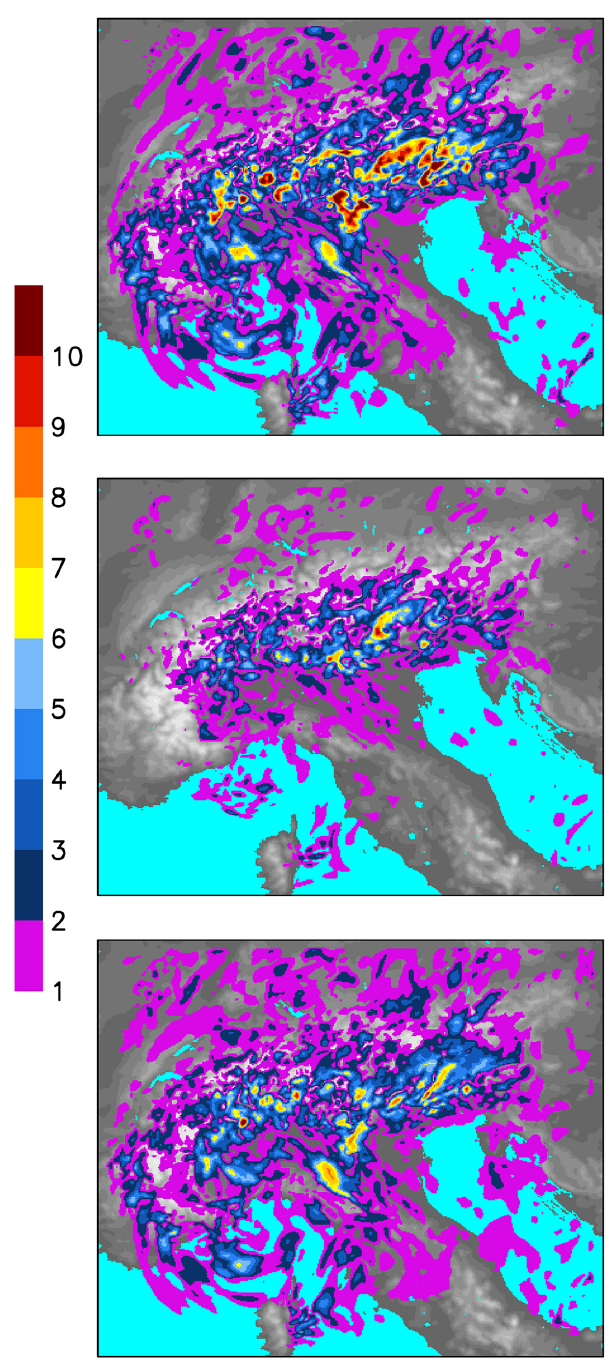
Figure 7. Maps of error at 03:00UTC on horizontal velocity (norm of two-dimensional vector differences, ms − 1 ). Top: error of con- trol state 18H (trajectory started with large initial error). Middle: projection of the error onto the 12BV subspace. Bottom: difference between the two above fields, i.e. error of the restart state of Fig.